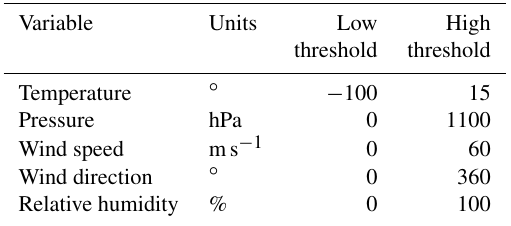
Table 2. Threshold values used in the quality control process for each measured